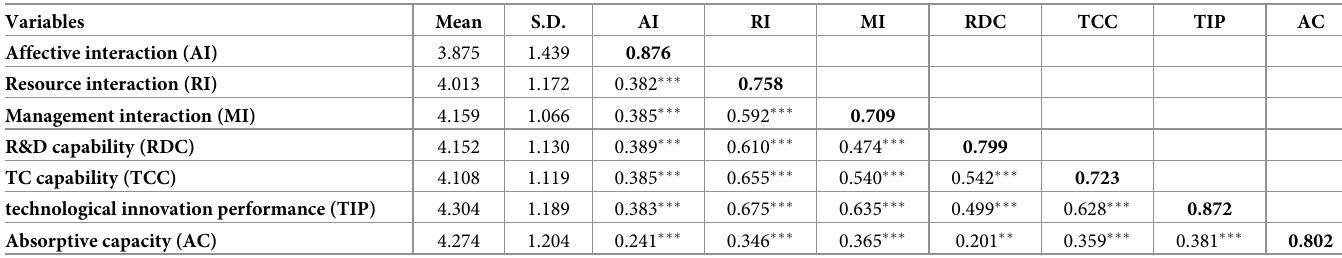
Table 1. Measure correlations, means, standard deviations (SD).